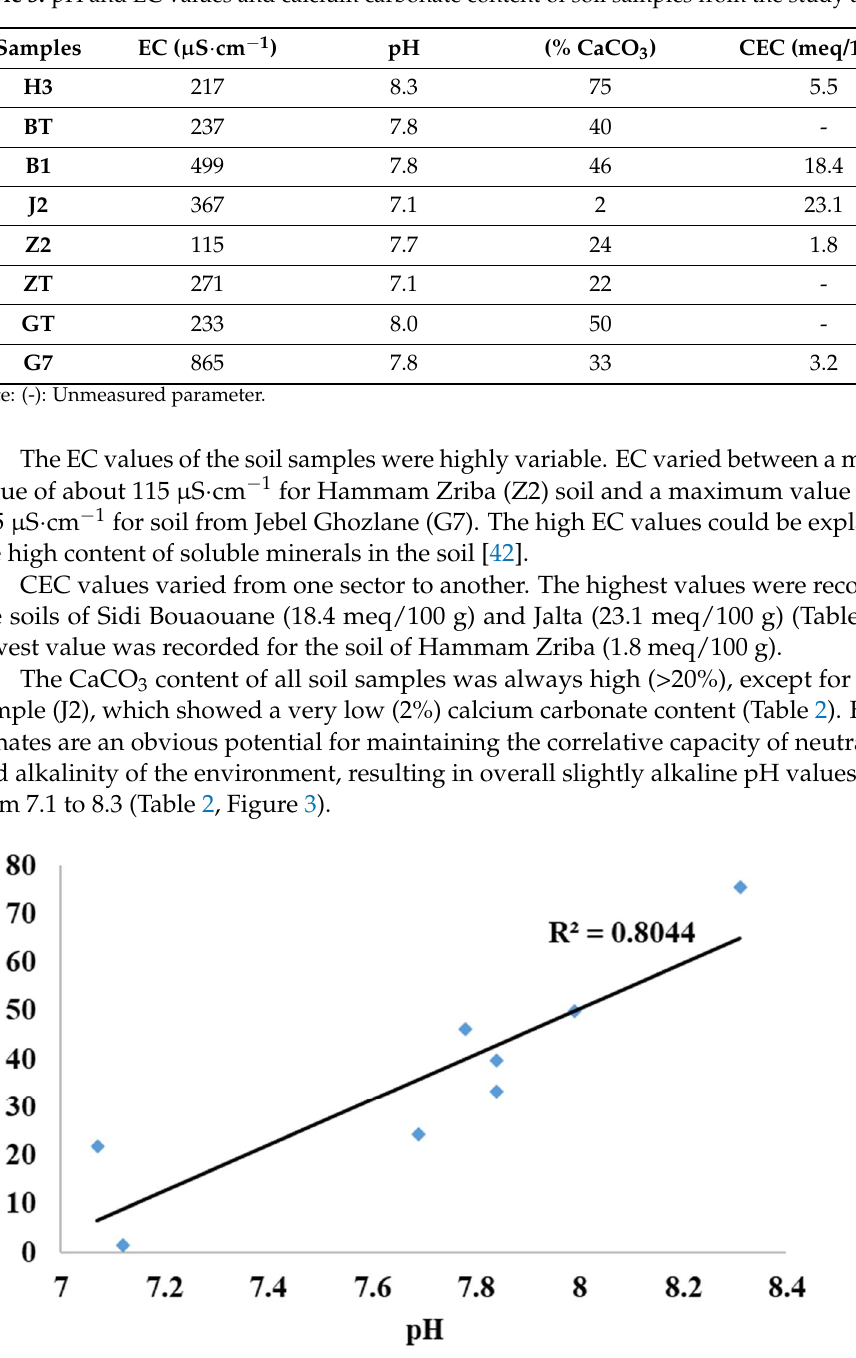
Figure 2. Triangular diagram of soil texture.